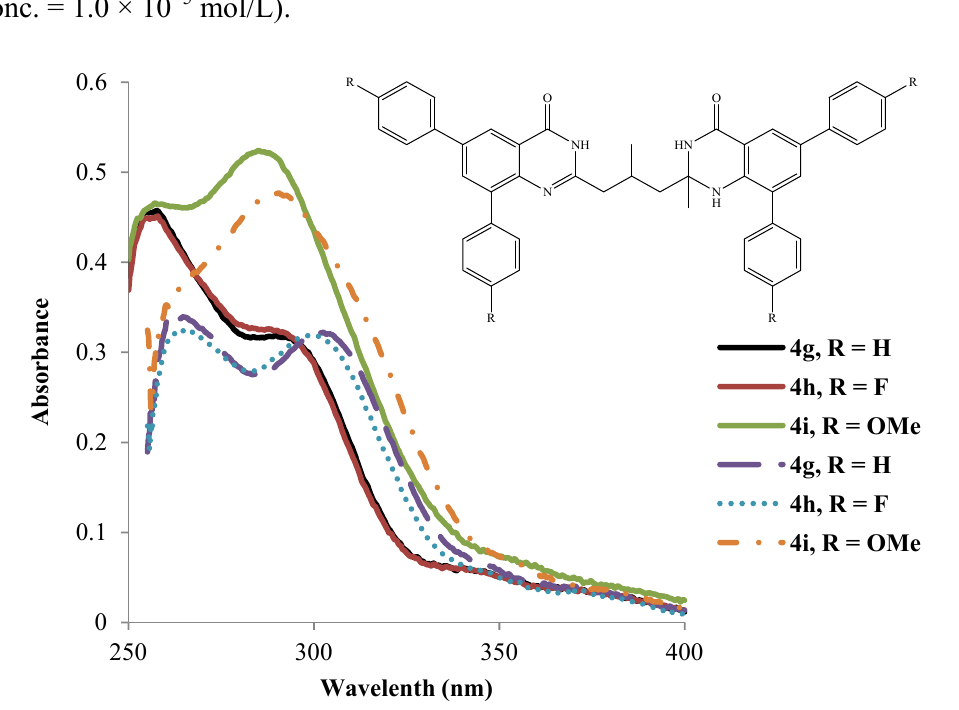
CO H (solid lines) at 3 2